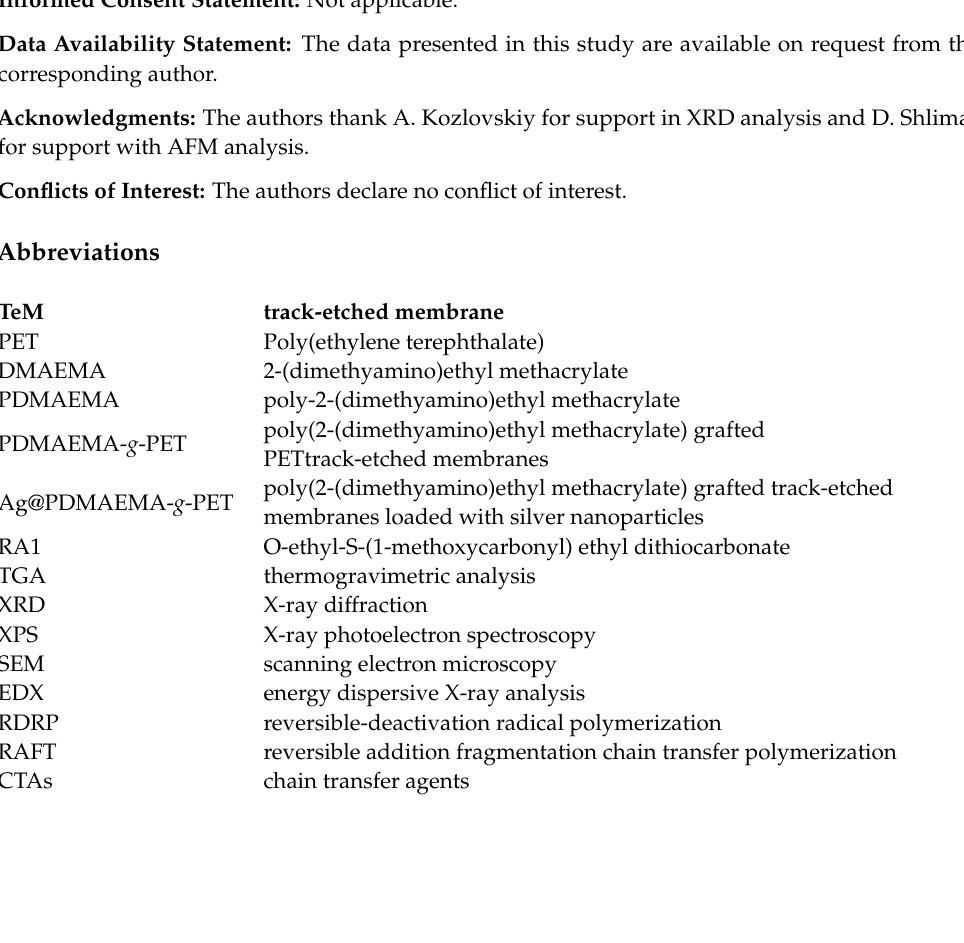
(h). Figure S2. Digital camera images of pristine PET TeM (a) and PDMAEMA grafted PET TeMs with degrees of grafting of 12% DG (b), 22% DG(c), 29% DG (d), 35% DG (e), and %43 DG (f). Figure S3. Contact angle (CA) measurements of (a) PDMAEMA grafted TeMs with DG of 22%, its quaternized membrane (b), PDMAEMA grafted TeMs (DG: 22%) with loaded Ag NPs (c),